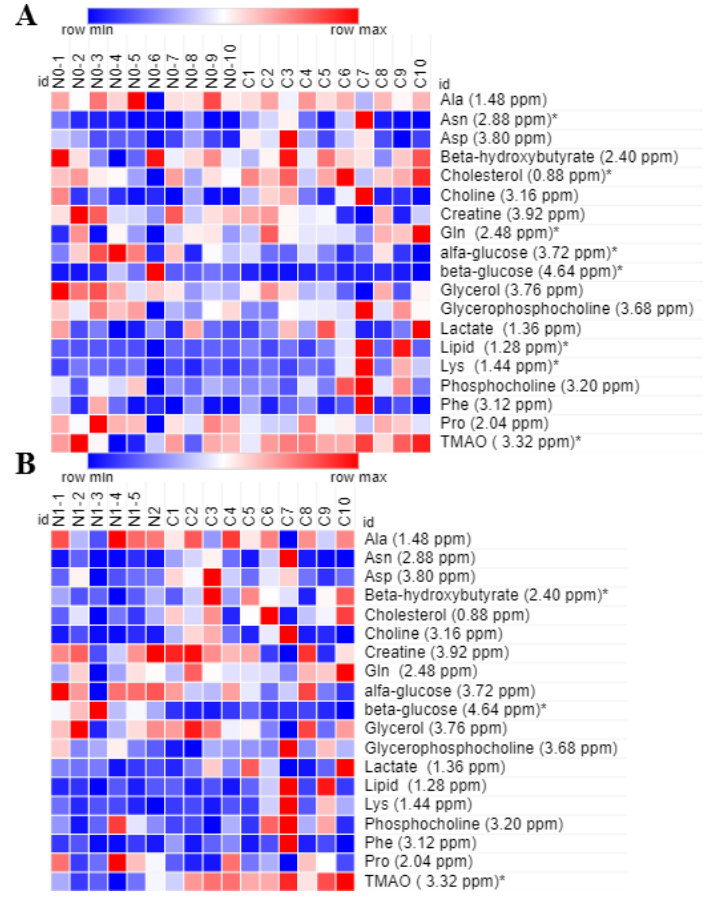
Figure 2 . Heatmaps of the most relevant metabolites (with a VIP value > 1) that were associated with the di ff erentiation between healthy controls (n = 10, group C) and: ( A ) BC patients with no lymph node metastasis (n = 10, group N0); and ( B ) BC patients with lymph node metastasis (n = 6, group N1 + N2). In columns are shown the di ff erent groups of women; in rows is reported the quanti fi cation of NMR integral bin regions of metabolites with VIP > 1, an * is used where signi fi cant di ff erences between groups are observed ( p -values < 0.05). Color scale indicates values ranging from blue (the lowest) to red (the highest).